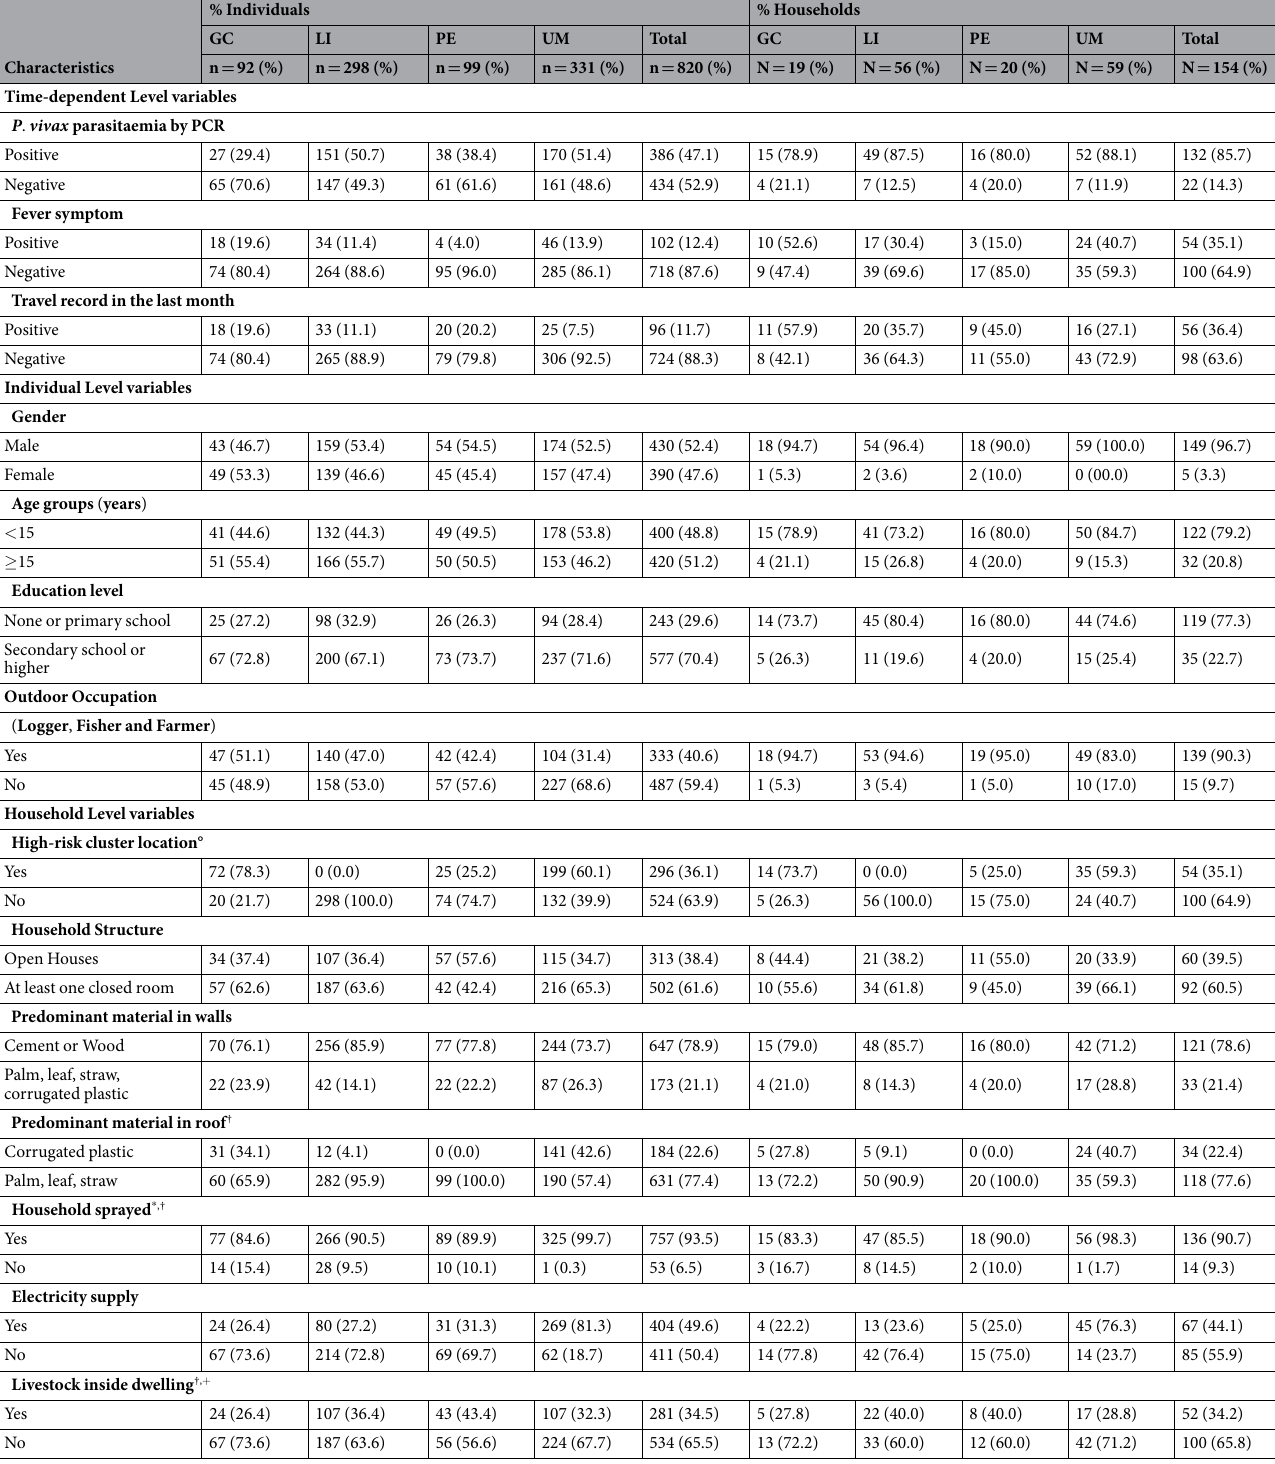
Table 1. Baseline characteristics of the study population. Proportions were expressed at a) individual level, where time-dependent variables were collapsed by calling it positive if there was at least one positive event at any of the time points (4 ACD surveys) and b) household level, where individual-dependent variables were collapsed based on whether at least one individual in the household had the reference